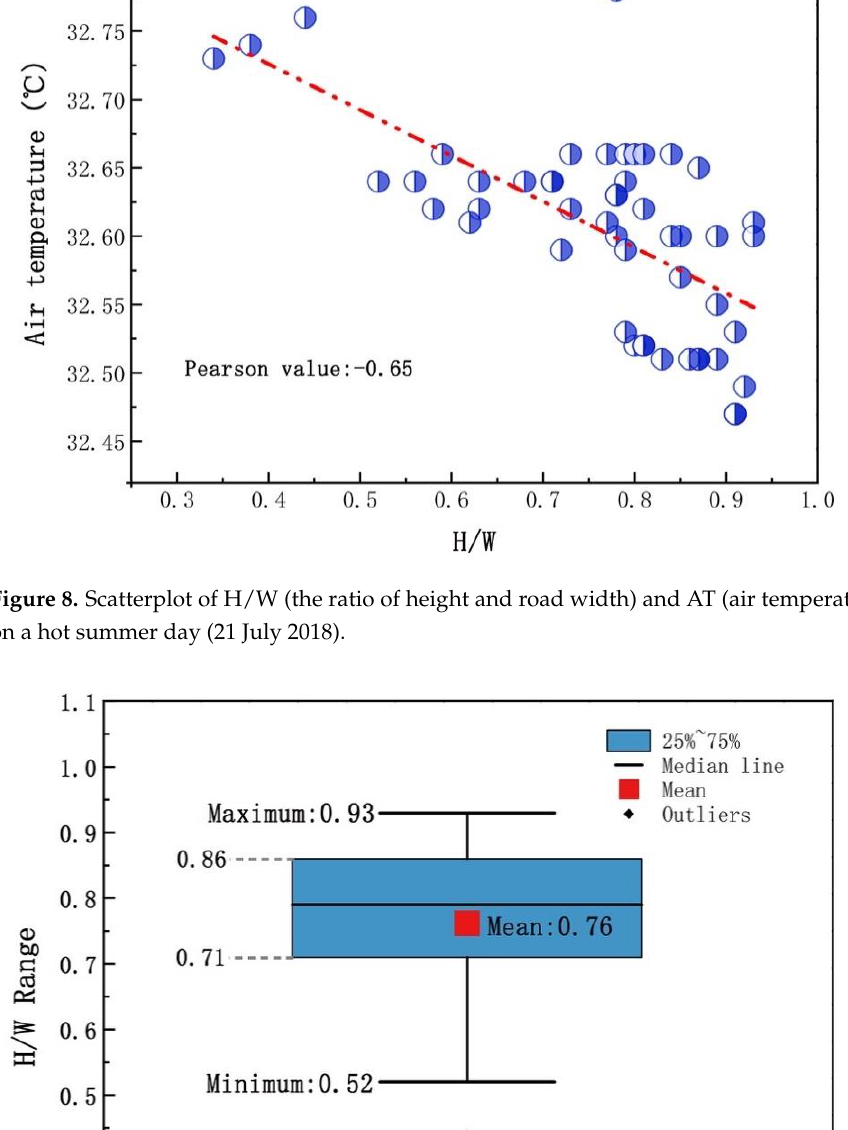
12 of 20 Figure 7. Standardized residual histograms ( a ) and P – P diagrams ( b ) of the regression model. 3.2.3. The Relationship between H/W and AT In order to further analyze the coupling relationship between H/W and village mi- croclimate environment, 50 AT simulation data at 13:00 in CJ village and DN village was obtained, which were evenly distributed in the villages, while calculating the correspond- ing H/W. Figure 8 shows the scatterplot of H/W and AT. Obviously, both of them are nega- tively correlated and the correl ation coefficient is −0.65, indicating a relatively strong cor- relation. Although the H/W data were not representative of everywhere in the village,